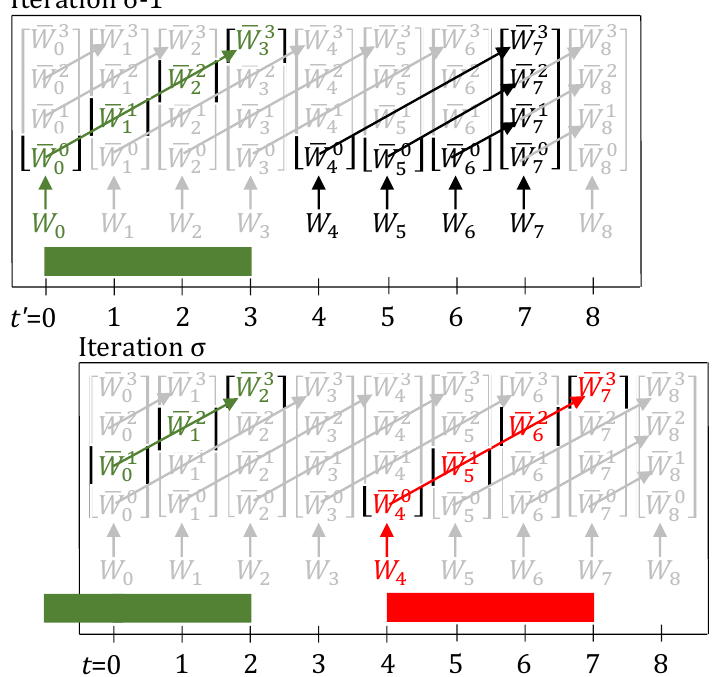
Figure 2. Task-states are shown for two online iterations – numbered σ − 1 and σ . Each iteration uses its own local time-grid which is reset to start from 0. Here, τ ij for the tasks is assumed to be 3. Lifting of past inputs enables knowing the complete status of the plant by looking at the states (variables) only at that moment in time. In the absence of delays or breakdowns, the lifting equations effectively = W ∀ j , i ∈ I represent the relation: ¯ W n j , n . Arrows show which variables are equal due to the ij ( t − n ) ijt lifting equations (Equations (11) and (12), with no delays or breakdowns). Variables in green or red have a value of 1, rest have value 0. Information is carried over from one iteration to the next through the update step (Equations